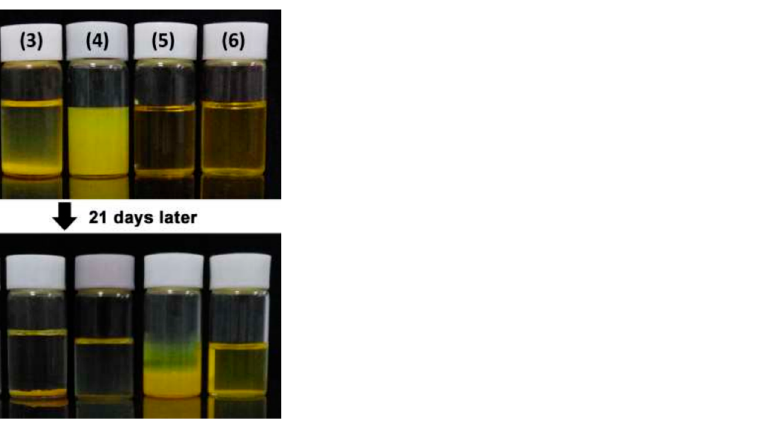
Figure 7. Photos of the double perovskite Cs 2 AgBiB r6 dispersed in various the solvents: (1) dimethyl formamide, (2) acetone, (3) isobutanol, (4) ethyl acetate, (5) chloroform, and (6) octane [128].